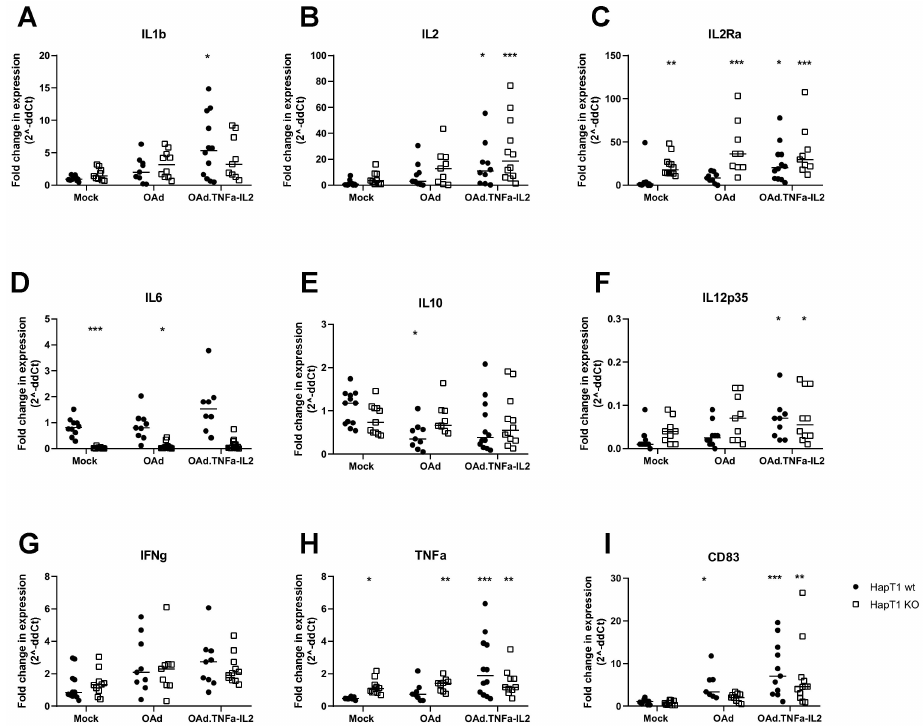
Figure 5. Determination of tumor microenvironment cytokine gene expression changes due to virotherapy: Virotherapy-treated subcutaneous HapT1 (AIM2 − / − KO or “wt”) tumors were collected and analyzed by RTqPCR for indicated markers of the immunological status of the tumor. ( A ) IL1b, ( B ) IL2, ( C ) IL2Ra, ( D ) IL6, ( E ) IL10, ( F ) IL12p35, ( G ) INFg, ( H ) TNFa, and ( I ) CD83.